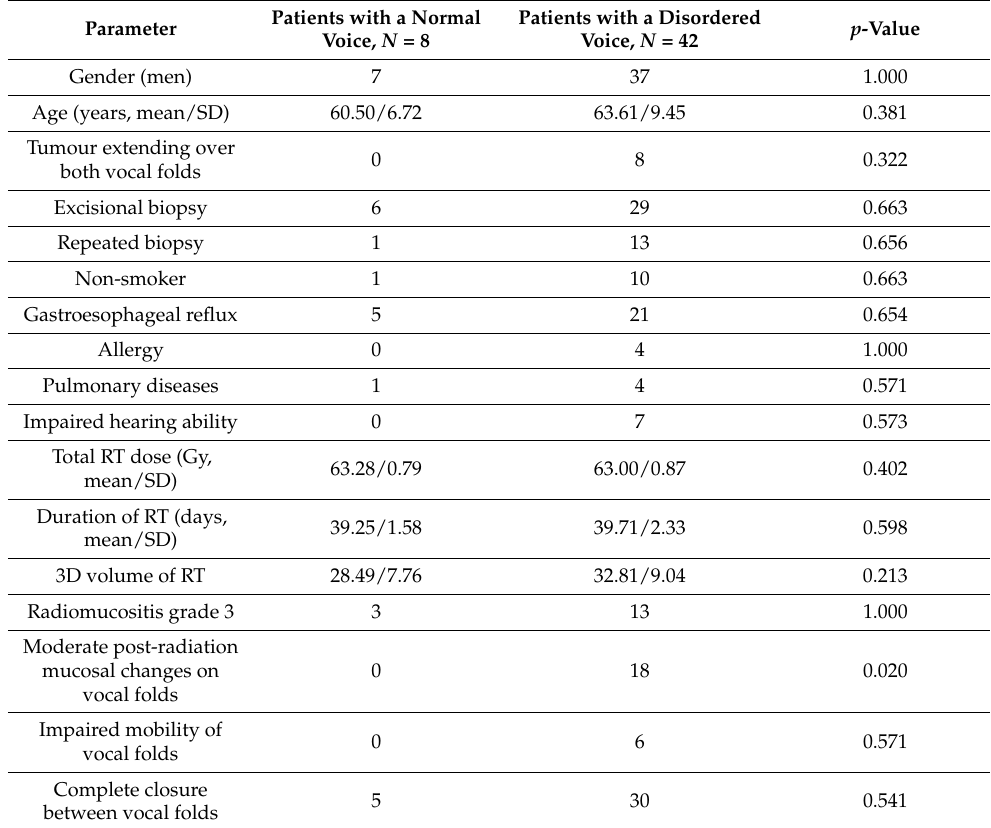
Table 3. Comparison between patients with a normal voice ( n = 8) and patients with a disordered voice ( N = 42) 24 months after radiotherapy. Patients with a Normal Patients with a Disordered p Parameter Voice, N = 8 Voice, N = 42